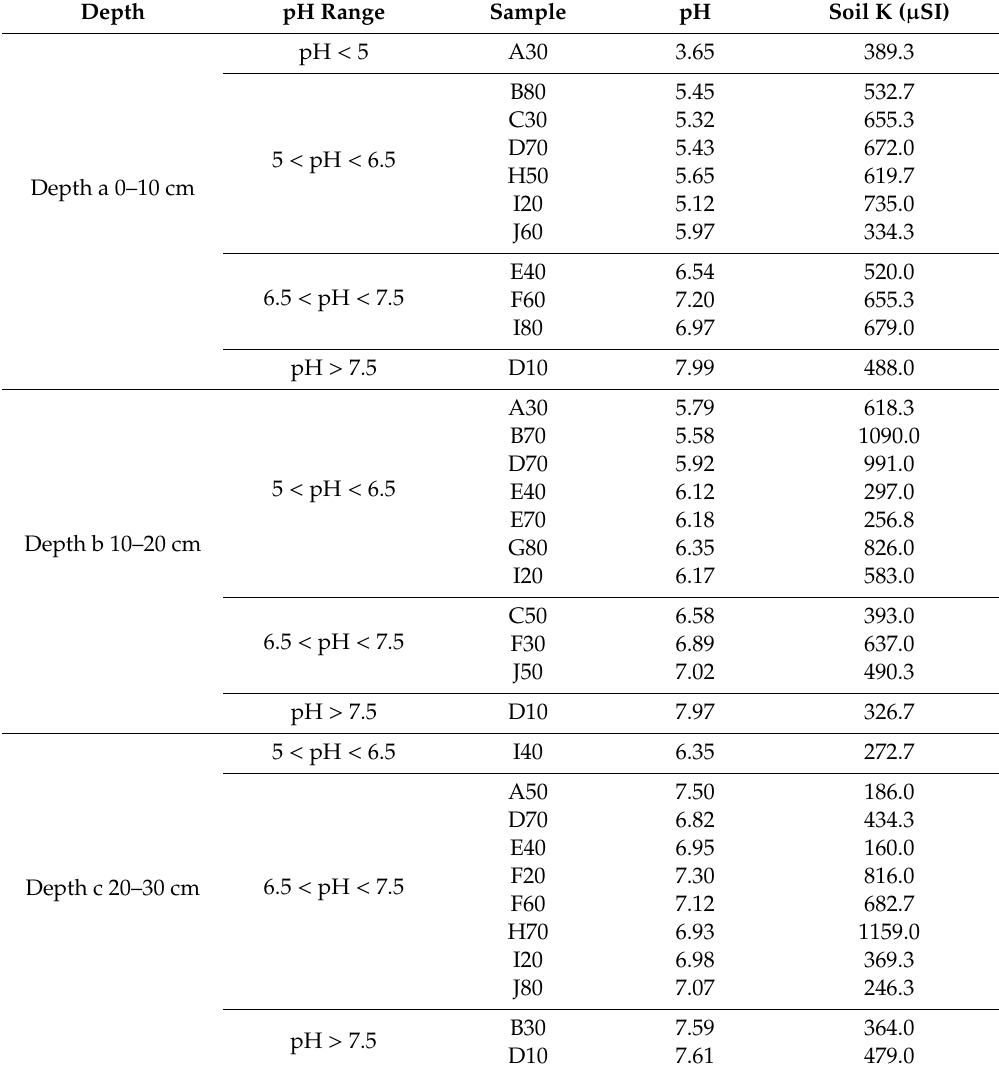
Table 2. Samples selected according to pH classes and magnetic susceptibility variability.